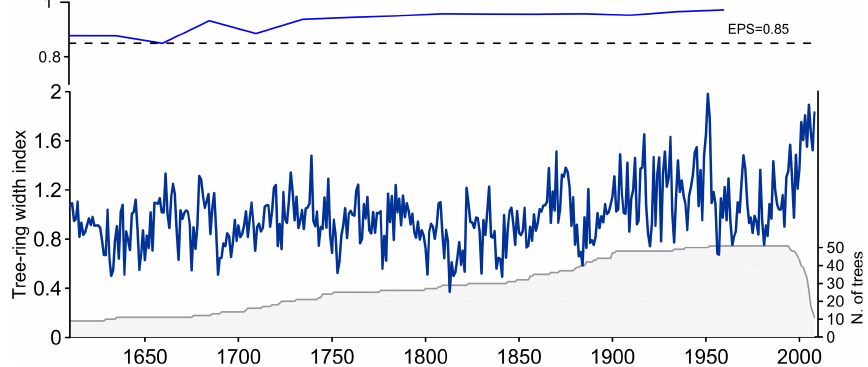
Fig. 2. The RCS AdaPres chronology with the expressed population signal (EPS) computed over 50-yr periods and shifted by 25yr back in time. Sample depth is on the bottom of the graph.